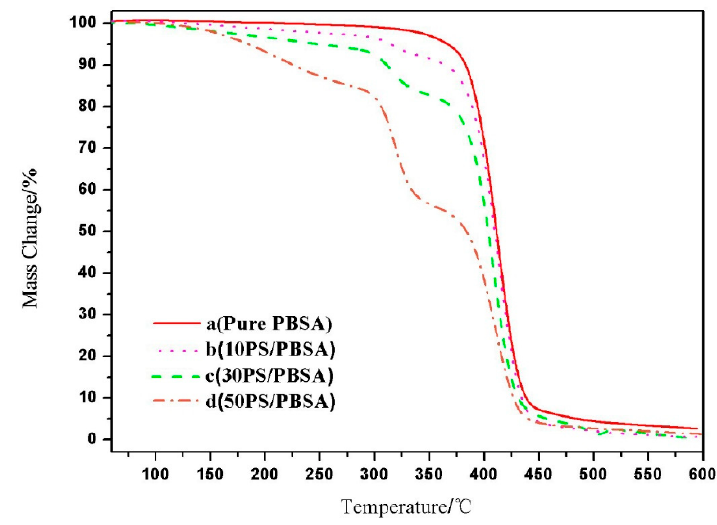
Figure 3. Thermal decomposition of the TPS/PBSA blend.